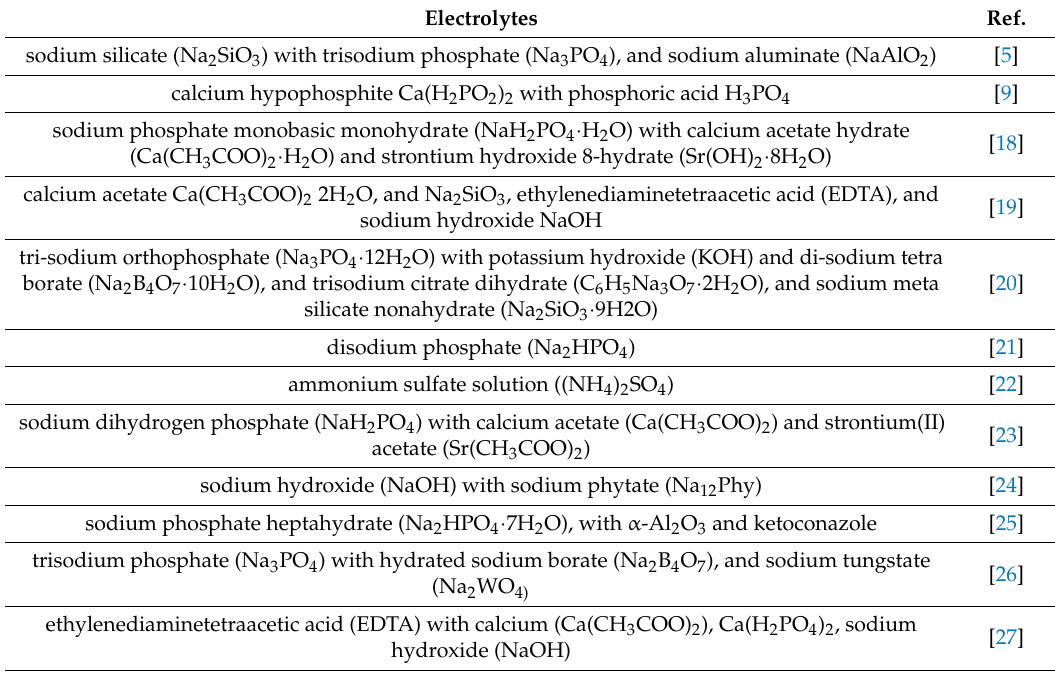
Table 1. Examples of aqueous electrolytes used to PEO (Plasma Electrolytic Oxidation) treatment of titanium and its alloys. Electrolytes